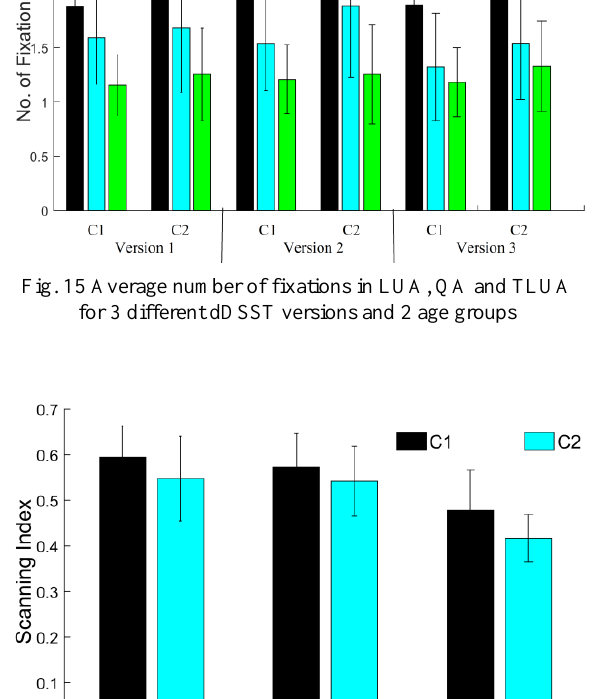
Table 9 Performance index (Average±(SD)) for 2 age groups ( C1 and C2 ).